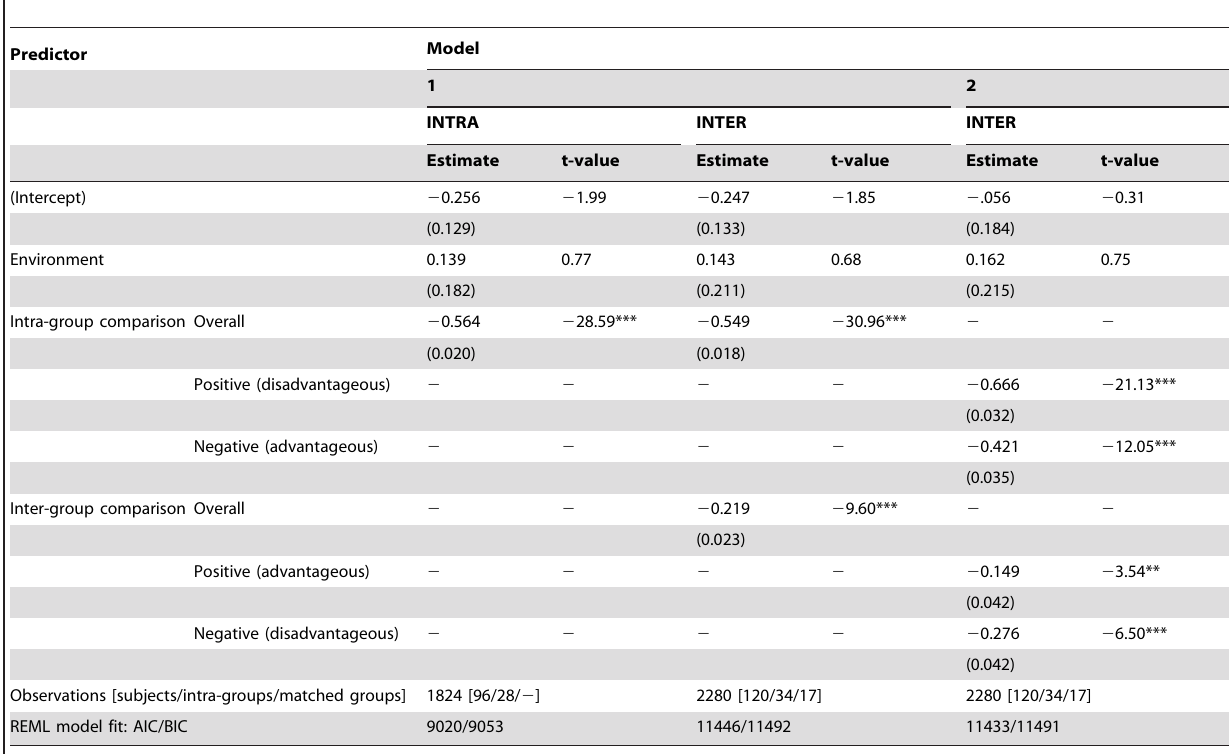
Table 2. Parameter estimates of mixed-effects models predicting contribution